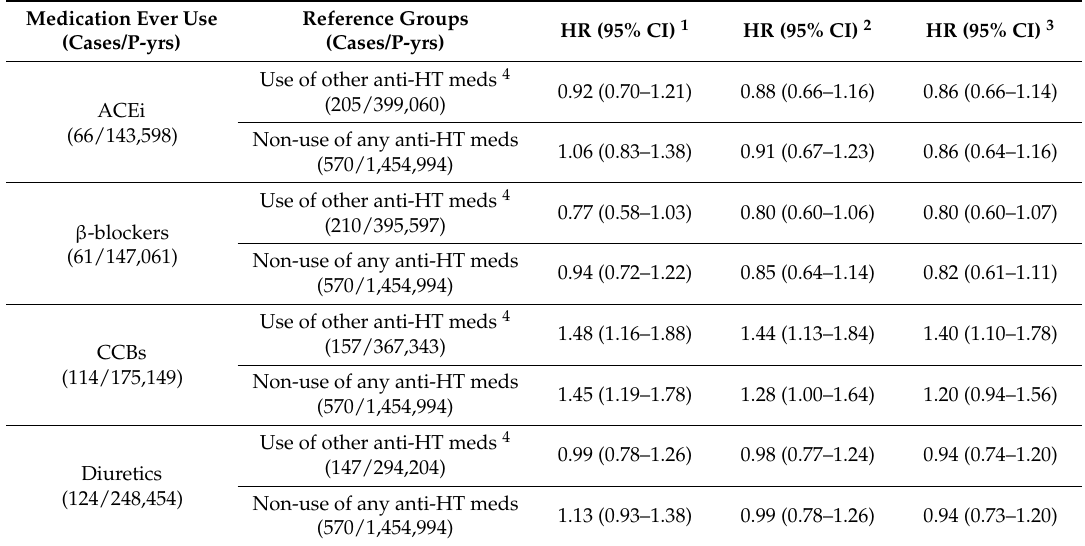
Table 2. Baseline antihypertensive medication use status in association with risk of incident pancreatic cancer. Medication Ever Use